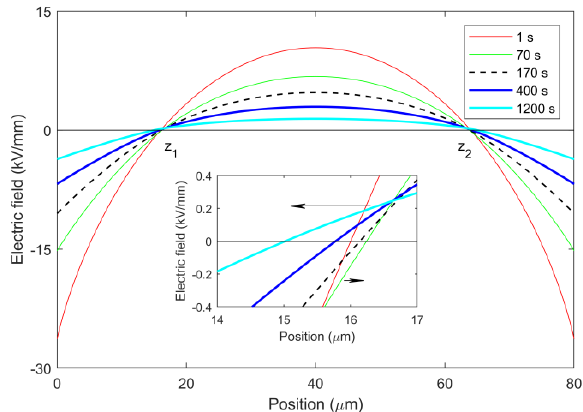
Figure 9. (a) Simulated discharge currents in studied materials at different temperatures. The inset displays the magnification of the plot including discharge currents at 60 °C. (b) Magnitude of simulated positive and negative current components in studied materials at 60 °C. Arrows indicate the reduction in magnitude of the current components due to the suppression of electrical conduction in the nanocomposite.